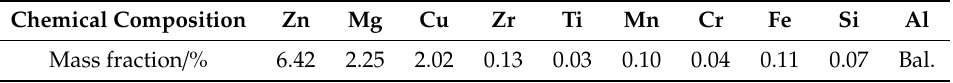
Table 1. Elemental composition and mass fraction of the 7050 aluminum alloy